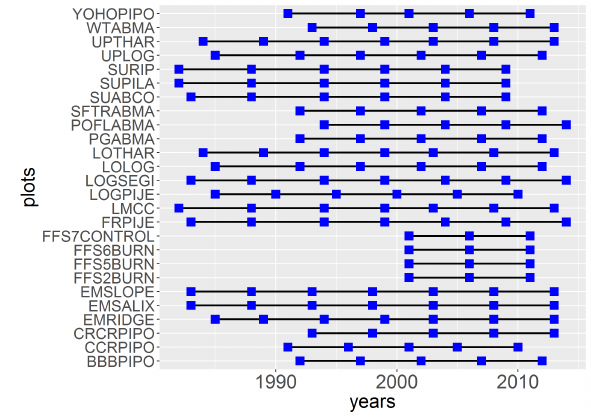
Figure A1. Years of DBH measurement for the different